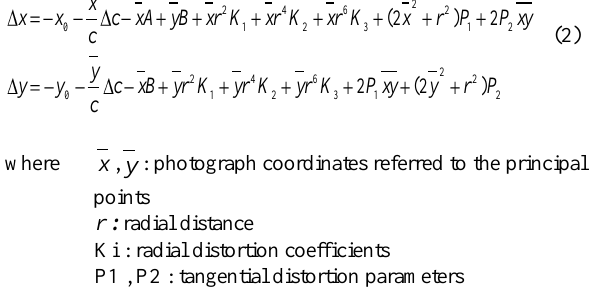
Figure 2. Nikon D3X SLR digital camera (a) and Flir